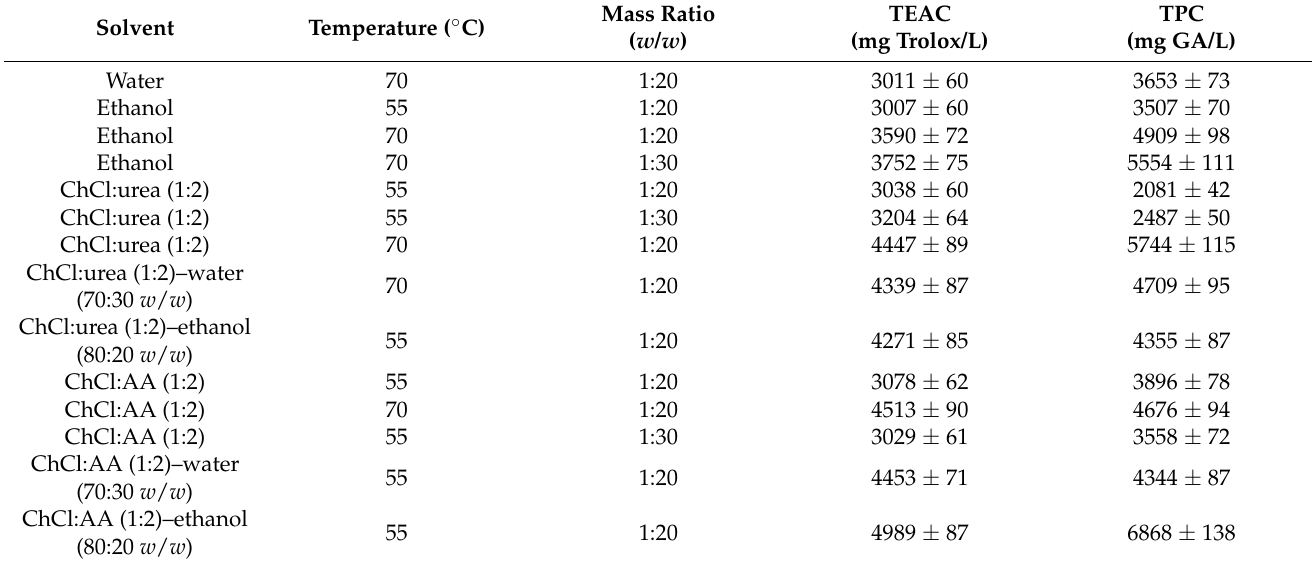
Table 3. Antioxidant activity and total phenolic content of the extracts obtained by conventional extraction.